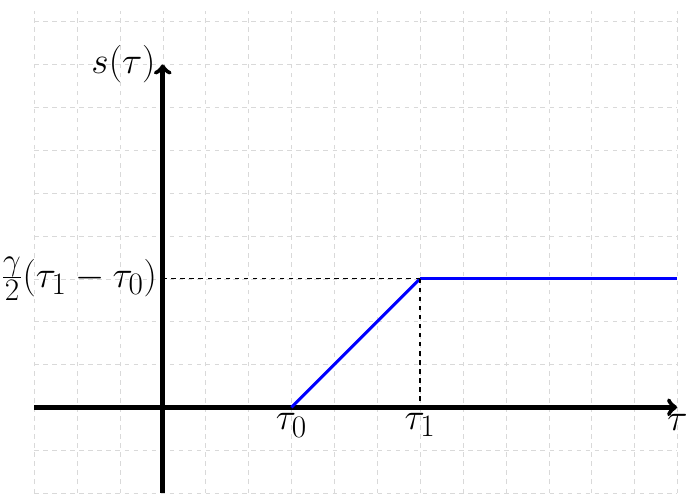
Figure 4 . The source term of the operator O 1 as a function of (cid:28) is depicted. We turn on the deformation only for the left side with s L = s ( (cid:28)